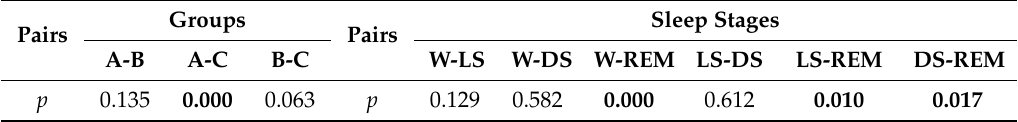
Table 4. Independent samples t-test of every possible pair.